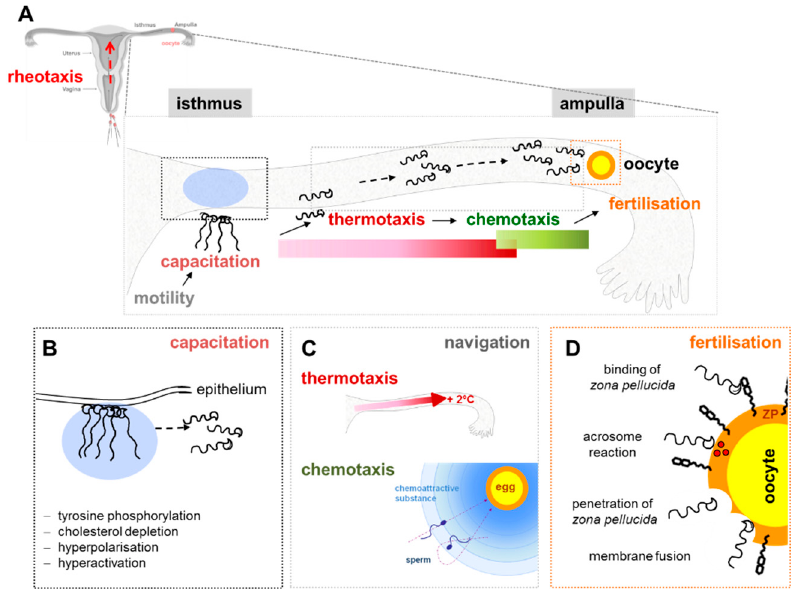
Figure 3. Schematic drawing showing the most critical steps during the sperm`s transit through the female genital tract before fertilizing the egg. The gamete interactions are a critical step on reproduction. Mammalian fertilization comprises: (i) sperm migration through the female reproductive tract (rheotaxis, thermotaxis and chemotaxis), (ii) biochemical and morphological changes to sperm (capacitation) and (iii) sperm ‐ egg interaction in the oviduct (fertilization) ( A ). In the female reproductive tract, specifically in the isthmus of the uterus, the mammalian sperm must undergo a series of important modifications, such as tyrosine phosphorylation, cholesterol depletion, hyperpolarisation and finally hyperactivation. These complex priming processes, by which sperm become competent to fertilize an egg, are all together termed “capacitation” ( B ). Chemotaxis permit sperm to move into the ampulla and locate the egg, organized in a cell complex ( C ). The ovulated oocyte is covered by a multicellular cumulus oophorous. The fertilization takes place after specific steps: ( i ) binding of zona pellucida , ( ii ) acrosome reaction, ( iii ) penetration of zona pellucida and ( iv ) final membrane fusion ( D